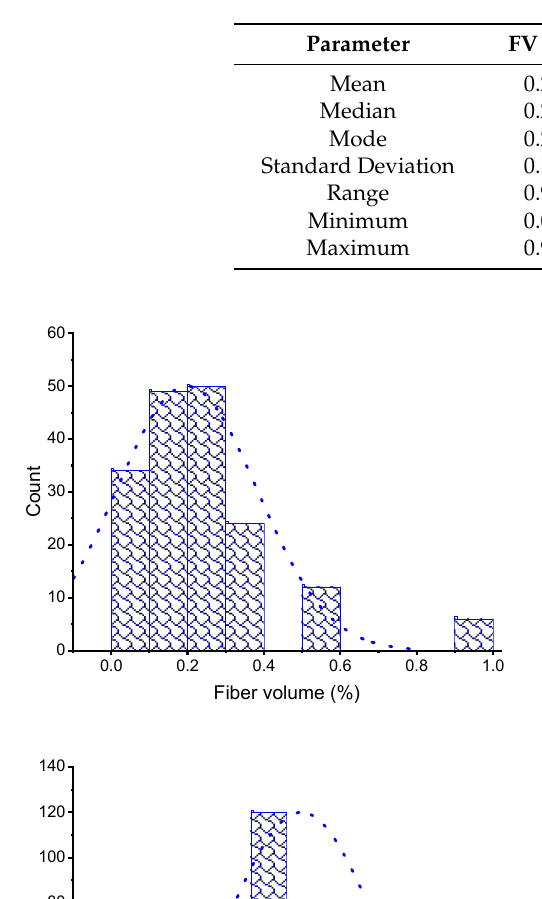
Table 1. The outcomes of the descriptive assessment of input parameters.